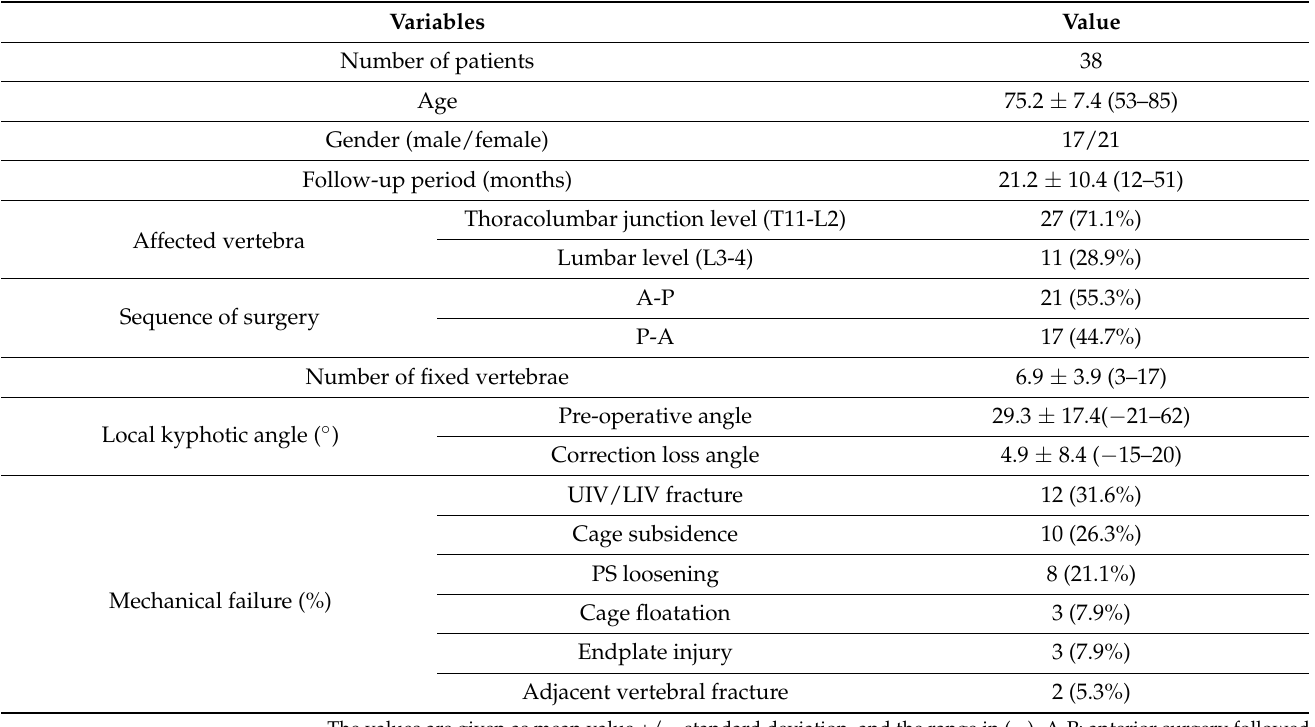
Table 1. Demographic data of patients and surgical